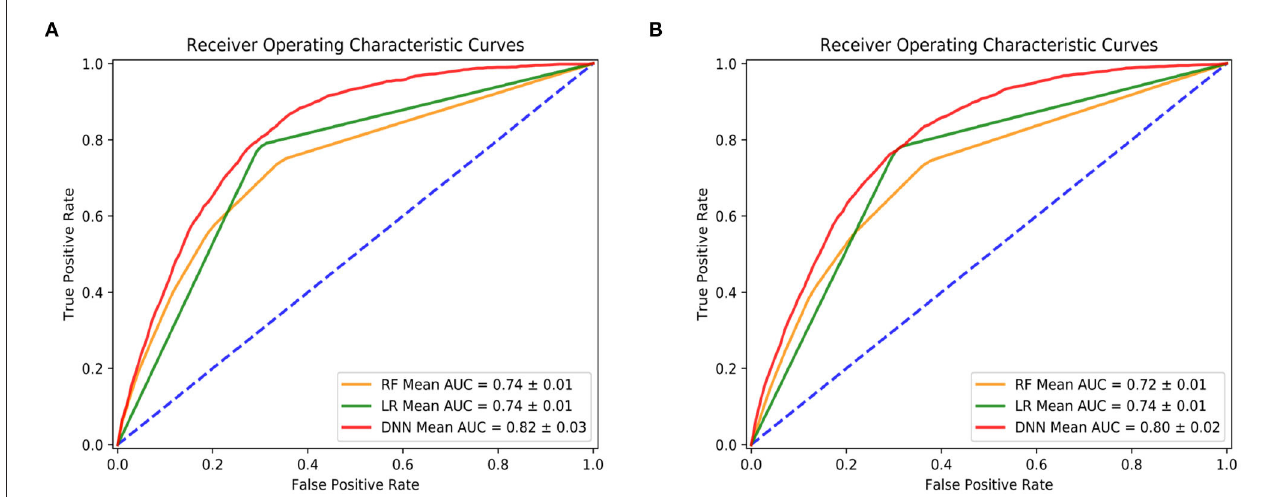
FIGURE 2 | Prediction performance by deep neural network (DNN), random forest (RF) and logistic regression (LR). (A) Is using features after and at heart failure diagnoses date; (B) is using features prior to and at heart failure diagnoses date.